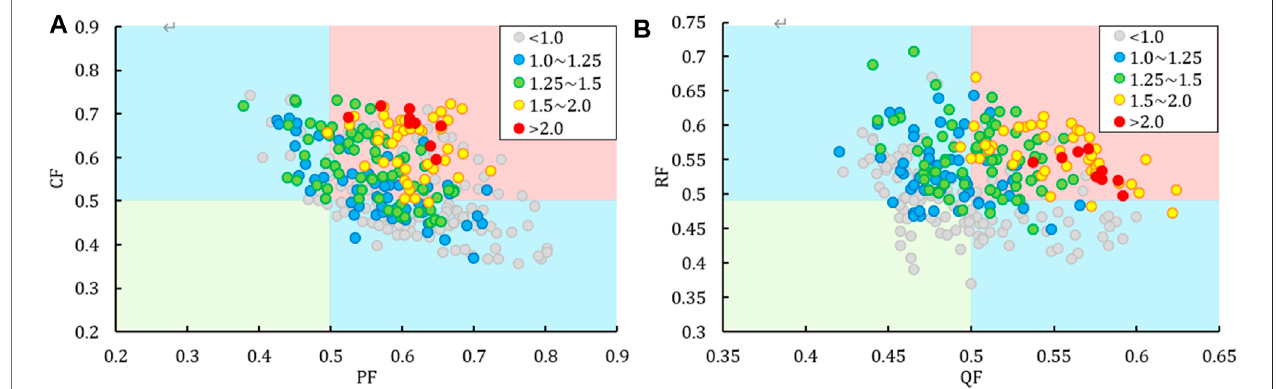
FIGURE 7 | Gas well production distribution corresponding to different evaluation charts (Sample well number 301).